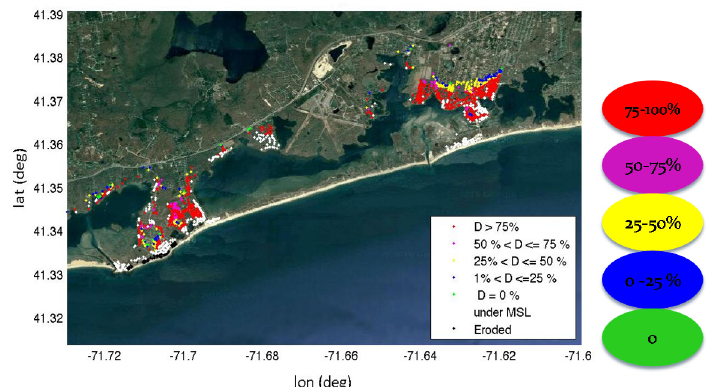
Figure 12. Percent damage by structure for Charlestown, RI for 100 year storm plus 2.1 m (7 ft) sea level rise (SLR), dunes eroded. Structures that are eliminated because they are below mean sea level (MSL) are noted by white dots and those removed by erosion are given by black dots. (See Figure A5 for higher resolution of these two categories).